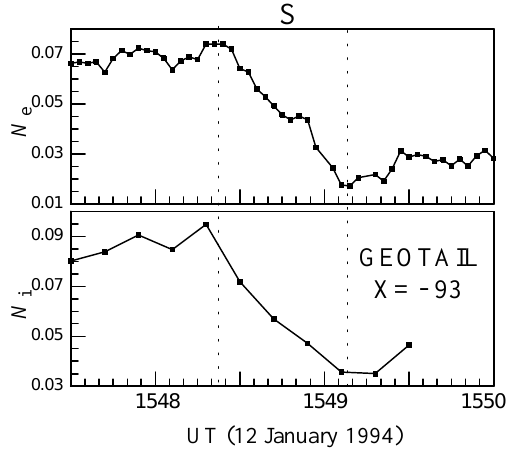
Fig. 5. The structure of plasma density observed inside a stand- alone slow shock.